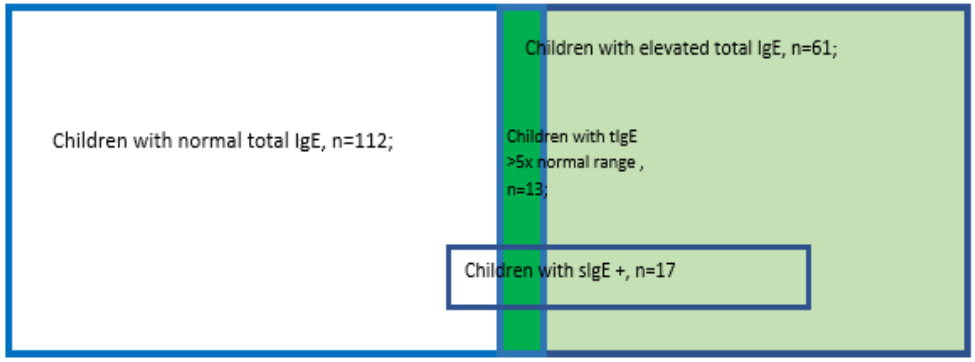
Figure 4. UC population structure.